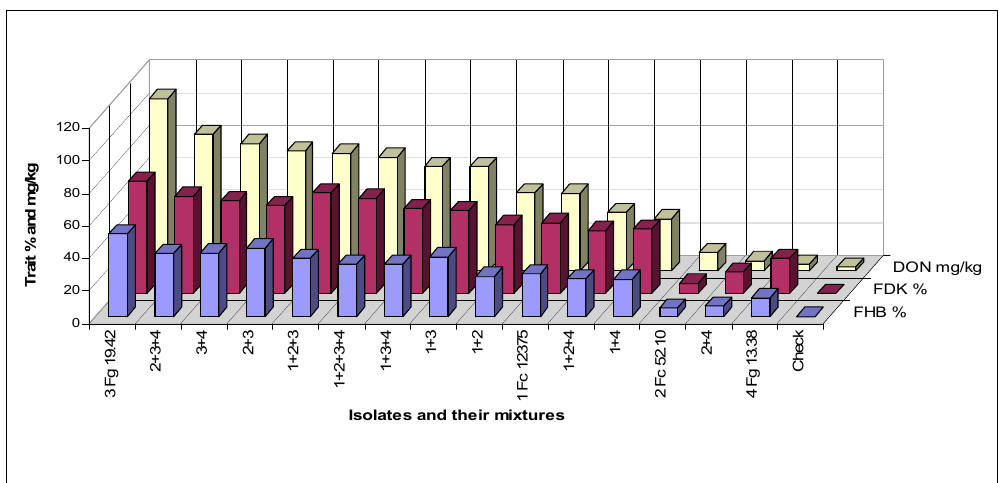
Figure 3. Mixtures and aggressiveness, means for the three traits, Szeged, 2013–2015. LSD 5% between any data for DI 2.06%, FDK 3.82% and DON 9.35 mg/kg.